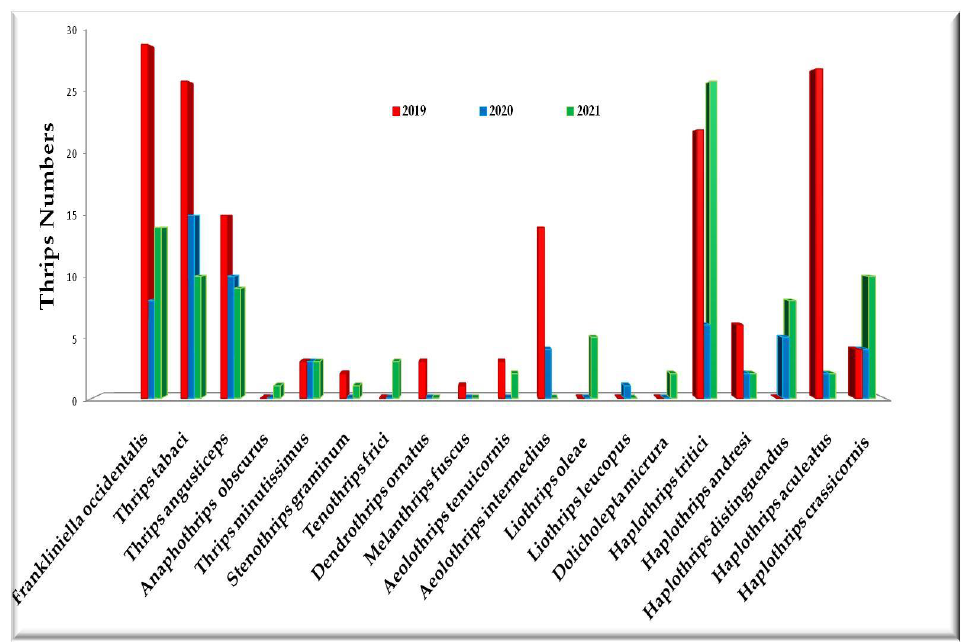
Figure 3. Temporal variation of thrips numbers in olive trees in the province of Batna (north-eastern Algeria) during the 2019/2021 period. Algeria) during the 2019/2021